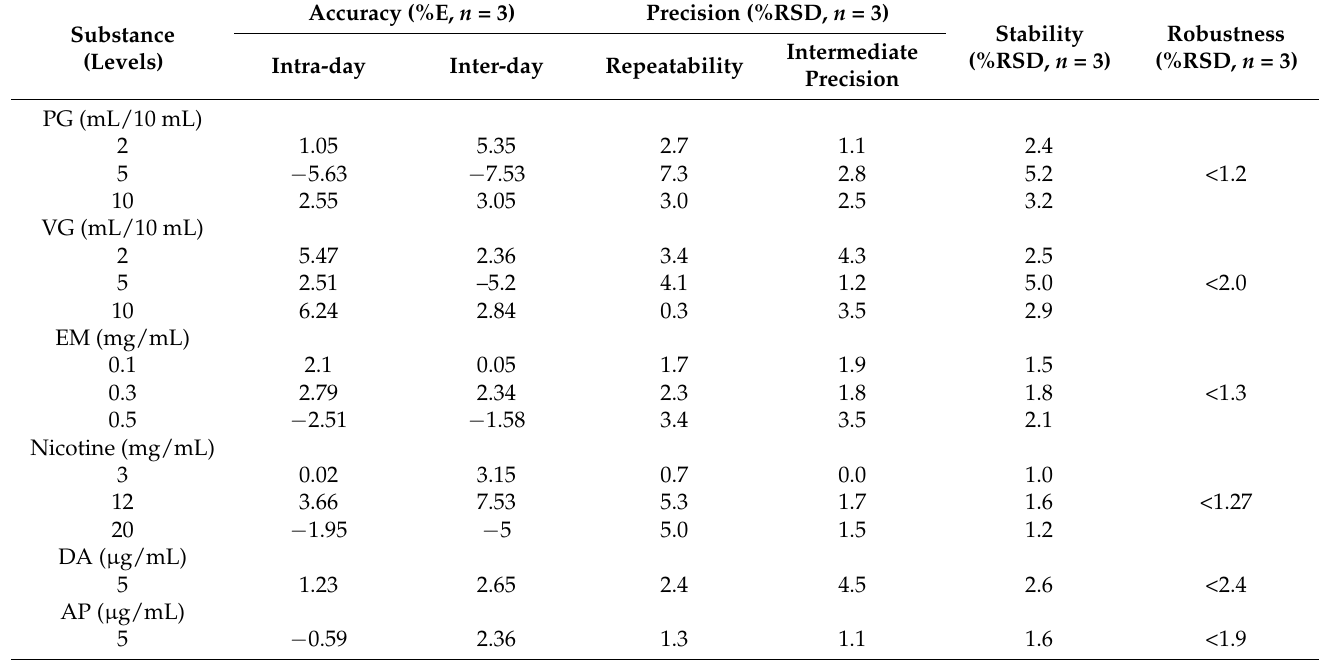
Table 2. Accuracy (intra-day and inter-day), repeatability, intermediate precision, stability, and robustness assessed for PG, VG, EM, nicotine, DA, and